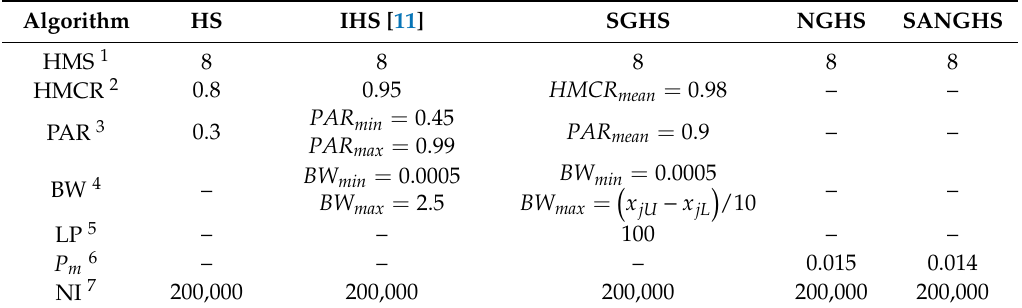
Table 8. Parameters of compared harmony search (HS) algorithms in the welded beam design engineering problem.